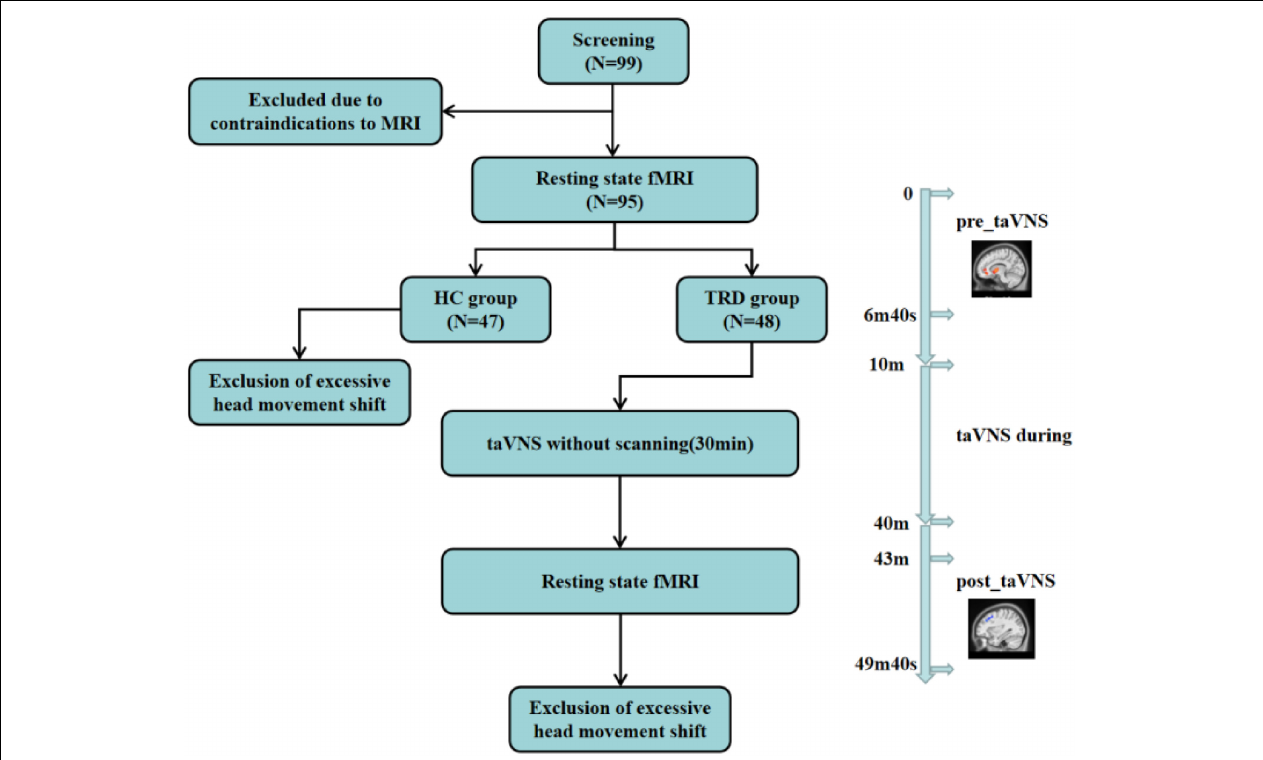
FIGURE 2 | This figure reflects to the experimental design, the subjects’ fMRI scans, the TRD patients treated with taVNS, and the exclusions. Resting-state brain imaging data were acquired using 3.0 T magnetic resonance imaging (MRI) at 3 min and 20 s before (“pre_taVNS”) and 3 min after (“post_taVNS”) taVNS. The taVNS was treated for 30 min immediately in the middle of the fMRI